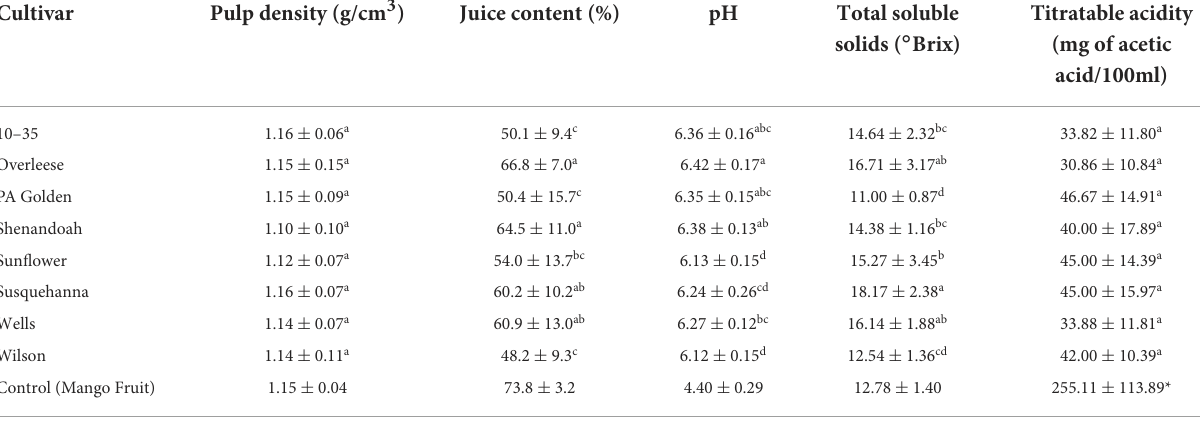
TABLE 3 Physicochemical properties of pawpaw fruits from different cultivars grown in southwest Missouri, 2020.